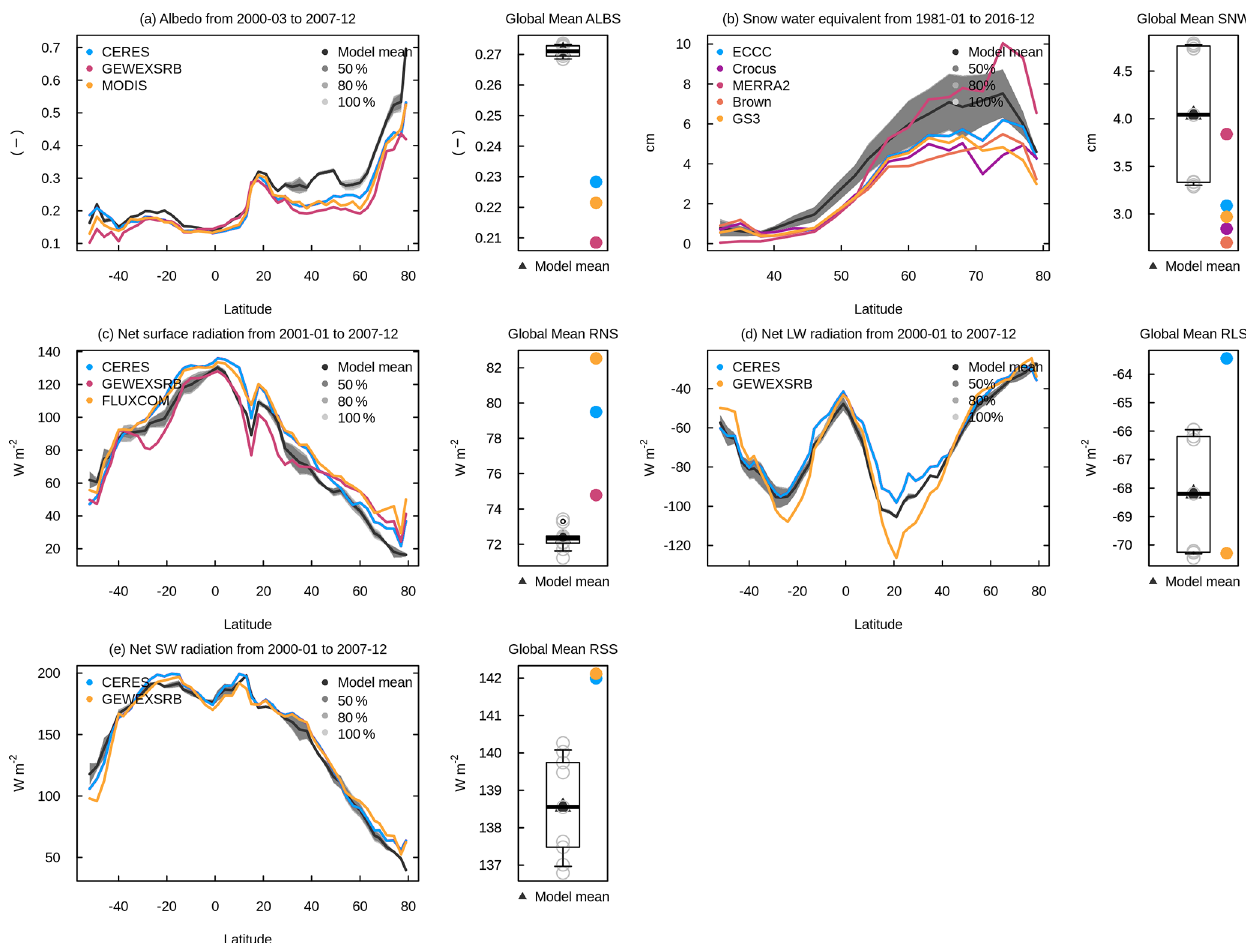
Figure A13. Zonally averaged values of surface albedo (a) , snow water equivalent (b) , net surface radiation (c) , net longwave radiation (d) , and net shortwave radiation (e) from the eight simulations summarized in Table 1. The model results are shown as their mean (black) and the spread across the eight simulations indicated by 50%, 80%, and 100% ranges in different shades of grey. The observation-based estimates used in AMBER to calculate scores are shown in coloured